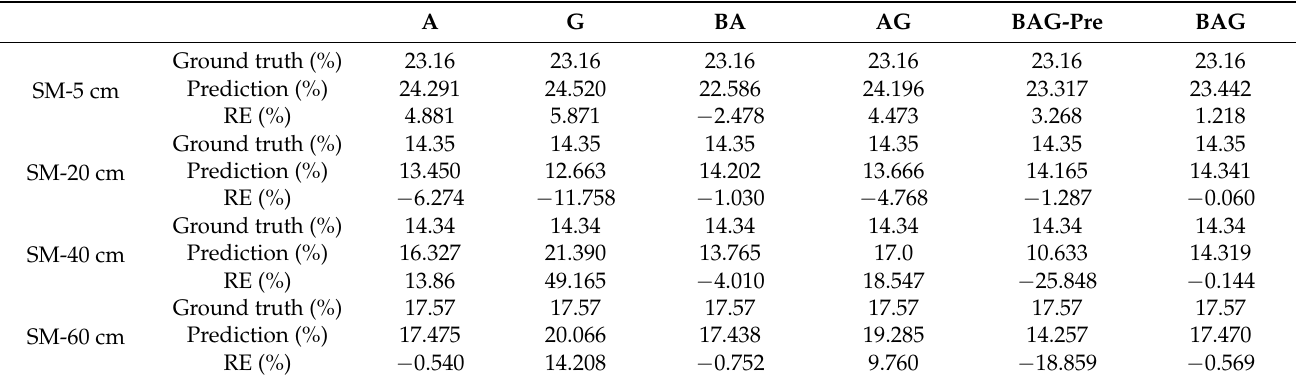
Table 12. Comparison results of different prediction